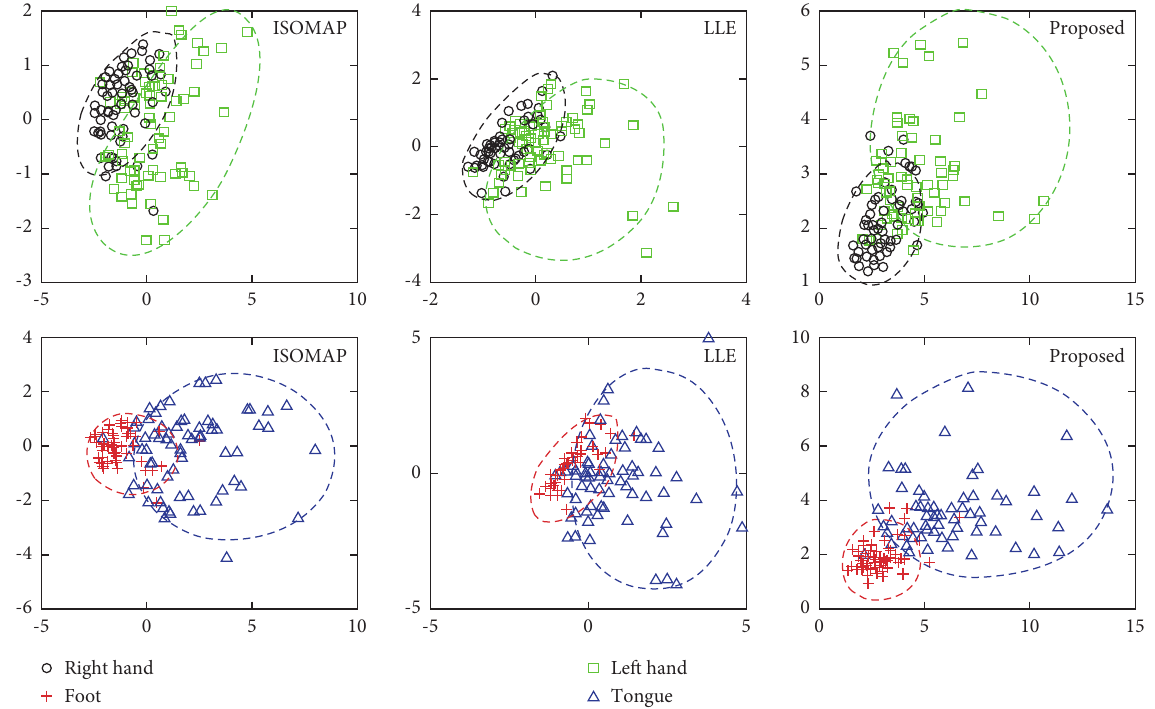
Figure 5: 2-dimensional embedding learning from ISOMAP, LLE, and proposed algorithm for subject 1 of BCI competition IV IIa. Right hand vs. left hand show in the first row, and foot vs. tongue show in the second